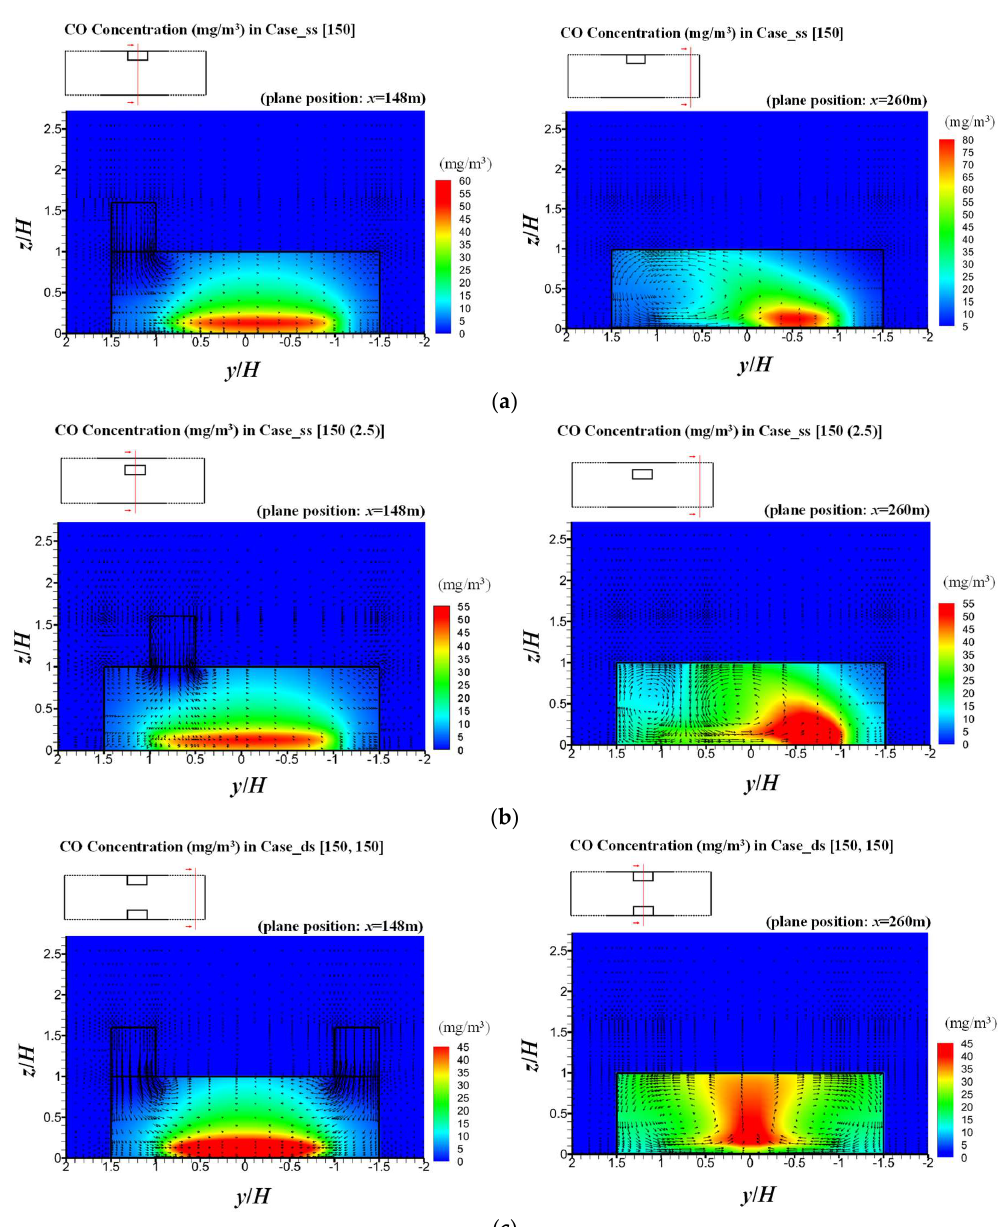
Figure 10. CO concentration on vertical cross section at x = 148 m ( x/L = 0.54) and x = 260 m ( x/L = 0.96) respectively. ( a ) Case_ss [150]; ( b ) Case_ss [150 (2.5)]; ( c ) Case_ds [150, 150].